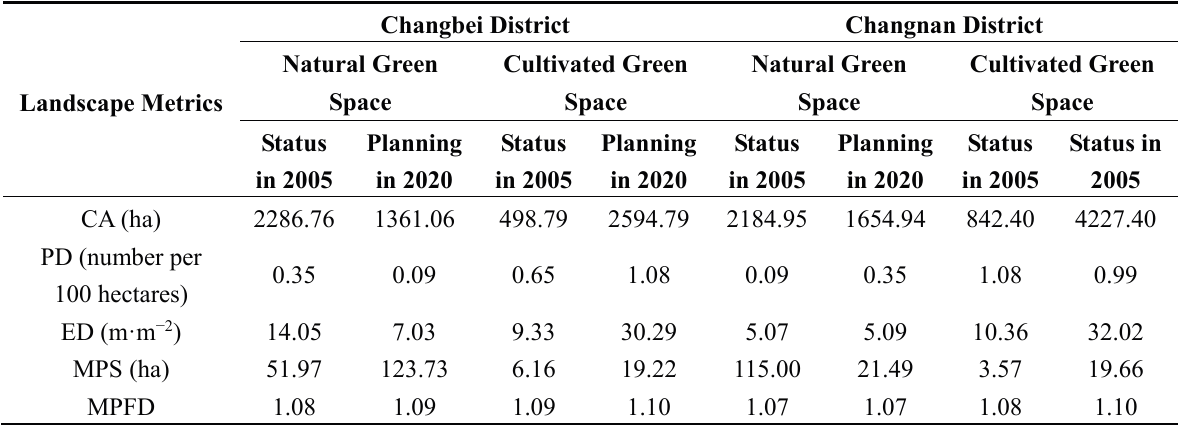
Table 1. The comparison of landscape metrics on class